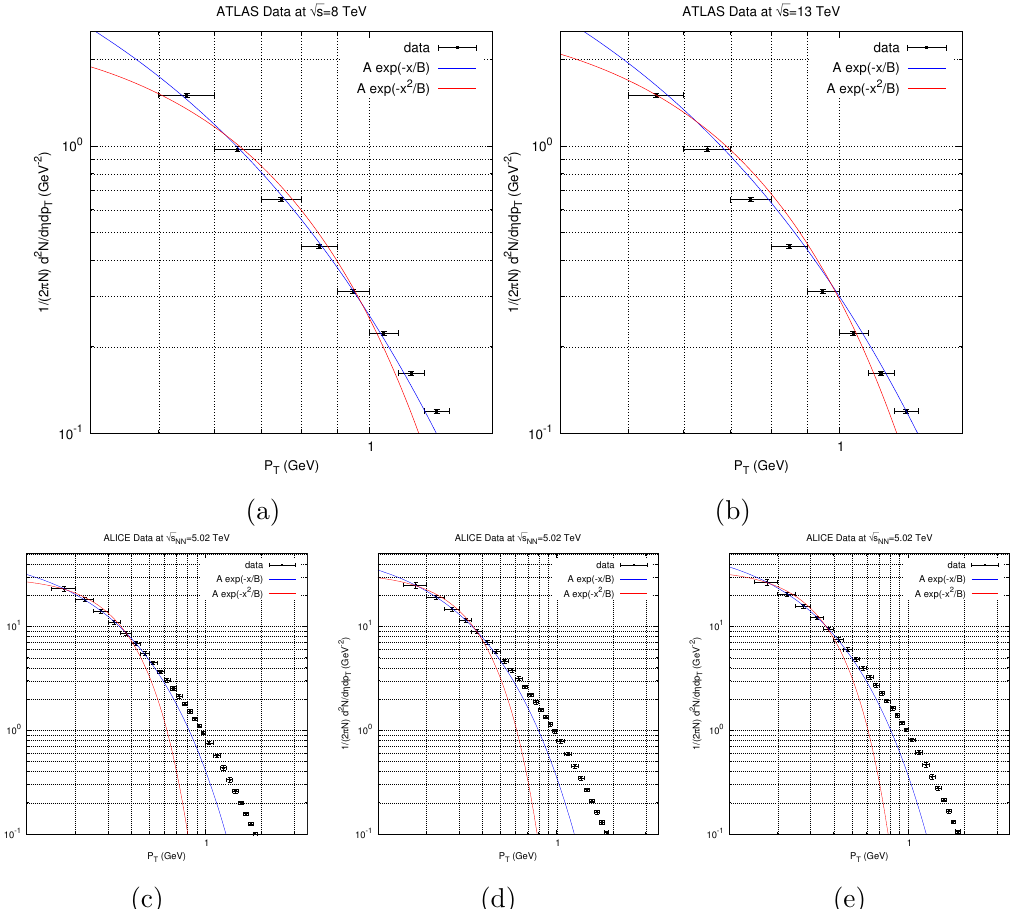
Figure 15. Fits of A exp ( p s = 8 TeV data set (a), the ATLAS p s = 13 TeV data set (b), the ALICE p s NN = 5 : 02 TeV 0 : 3 data set (c), the ALICE p s NN = 5 : 02 TeV p s NN = 5 : 02 TeV